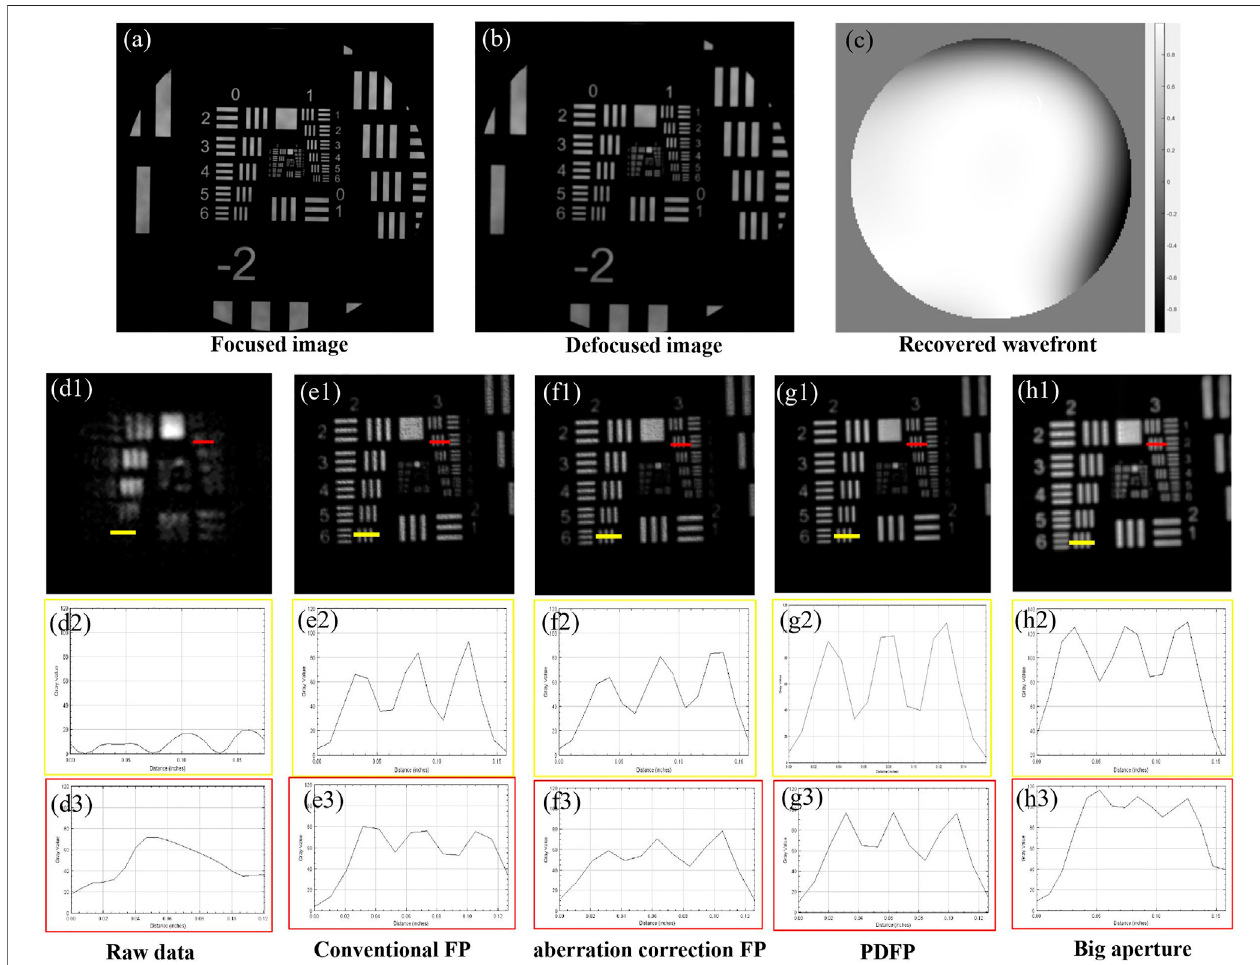
FIGURE5 | The experimental results bythe conventional Fourier ptychography (FP), aberration correction FP, and the proposed phase diversity-based FP (PDFP) method. (A) The focused image. (B) The defocused image. (C) The recovered pupil phase. (D1) Low-resolution raw data. (E1) The recovered results with conventional FP. (F1) The result by aberration correction FP. (F1) The correction results of our PDFP method. (D2 – H2) Line pro fi les of group 2 element 6 panels (D1 – H1) . (D3 – H3) Line pro fi les of group 3 element 2.